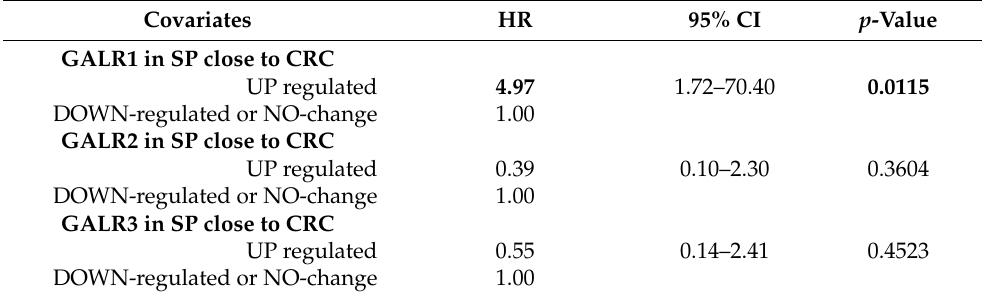
Table 4. Association between demographic and clinico-pathological features of colorectal (CRC)